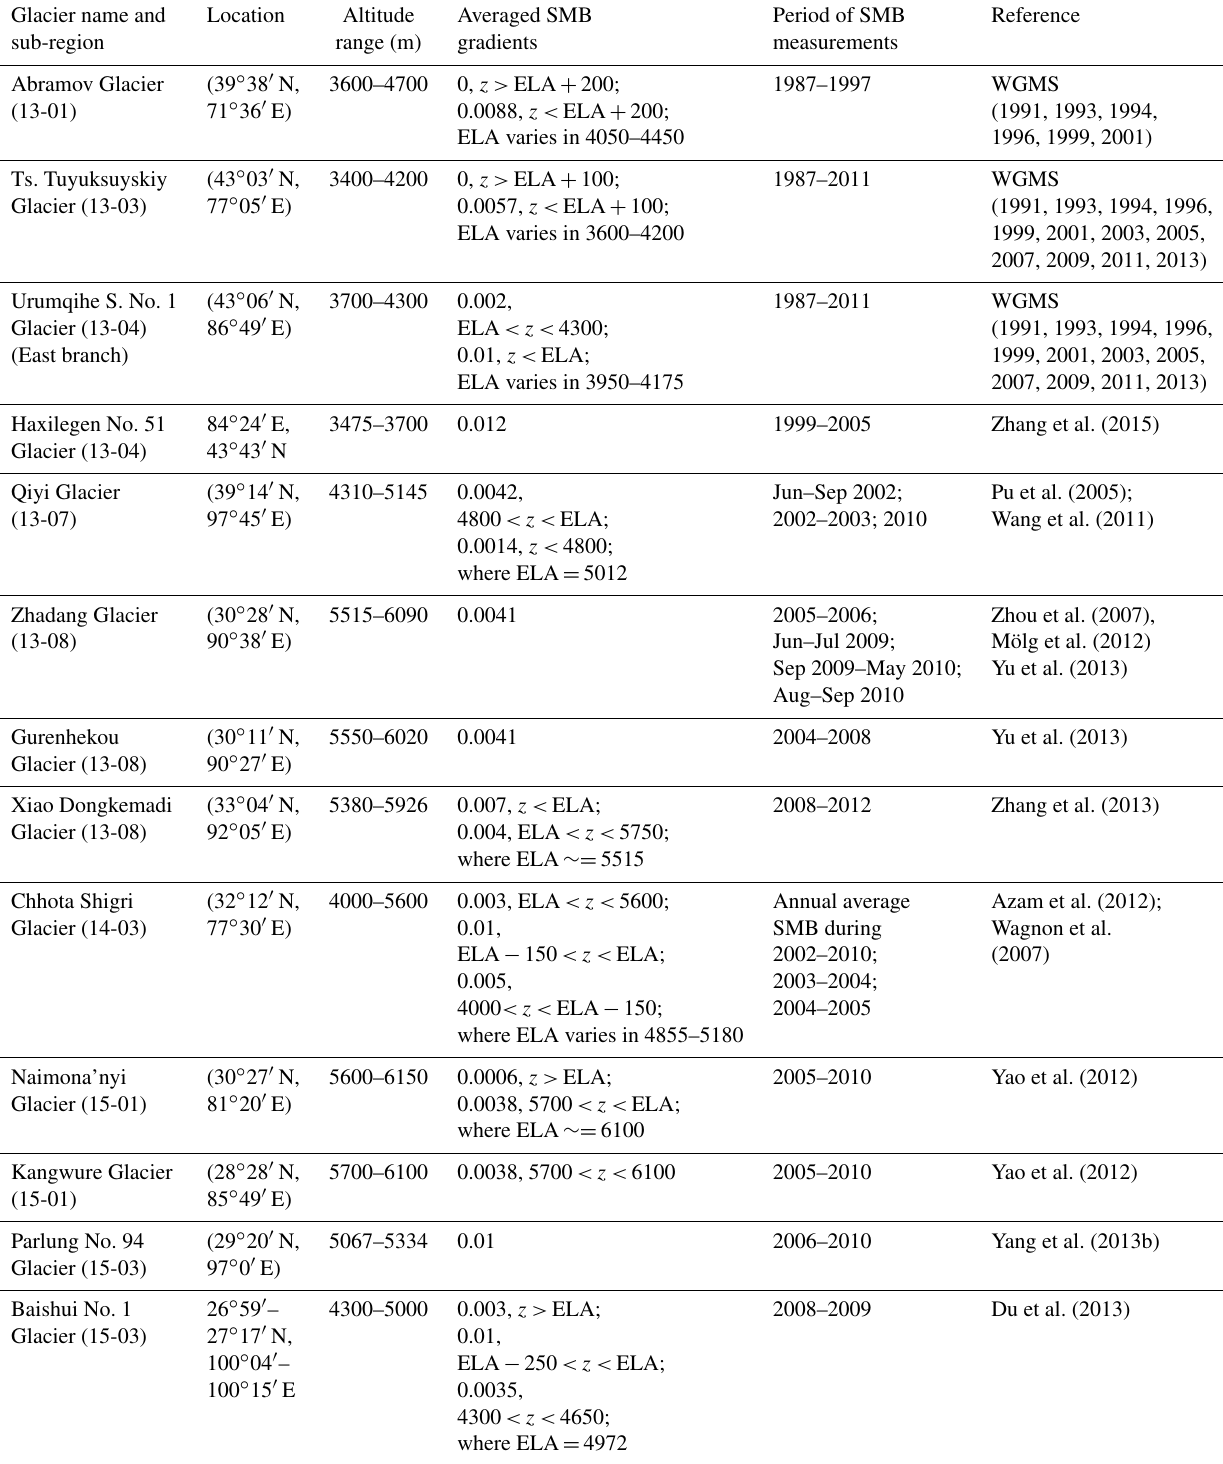
Table 1. The benchmark glaciers; their RGI 5.0 sub-regions; and their exact location (Fig. 1), altitude range, averaged SMB gradients (unit: mm − 1 ) in specific altitude intervals, and ELA and SMB data